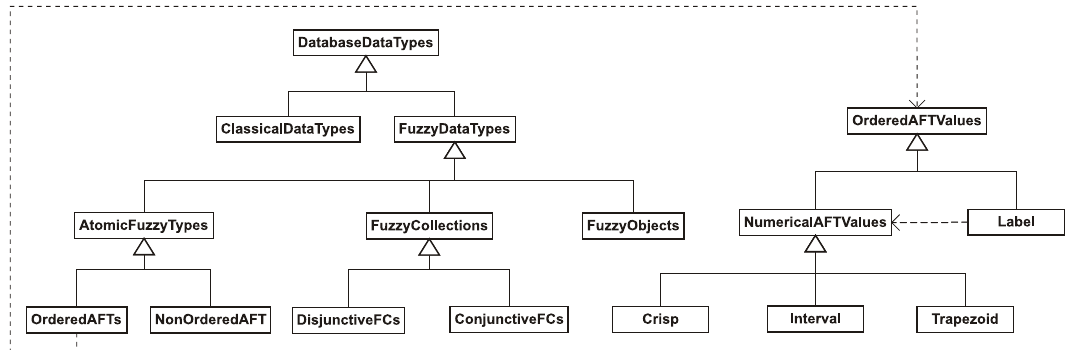
Fig. 1. Datatype hierarchy for the